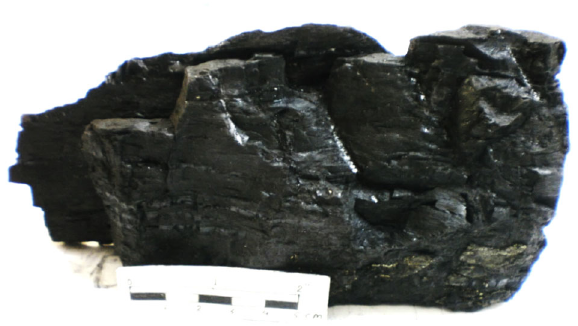
Fig. 1 A cross-section through a lump of coal showing vitrain, clarain, durain and fusain bands with